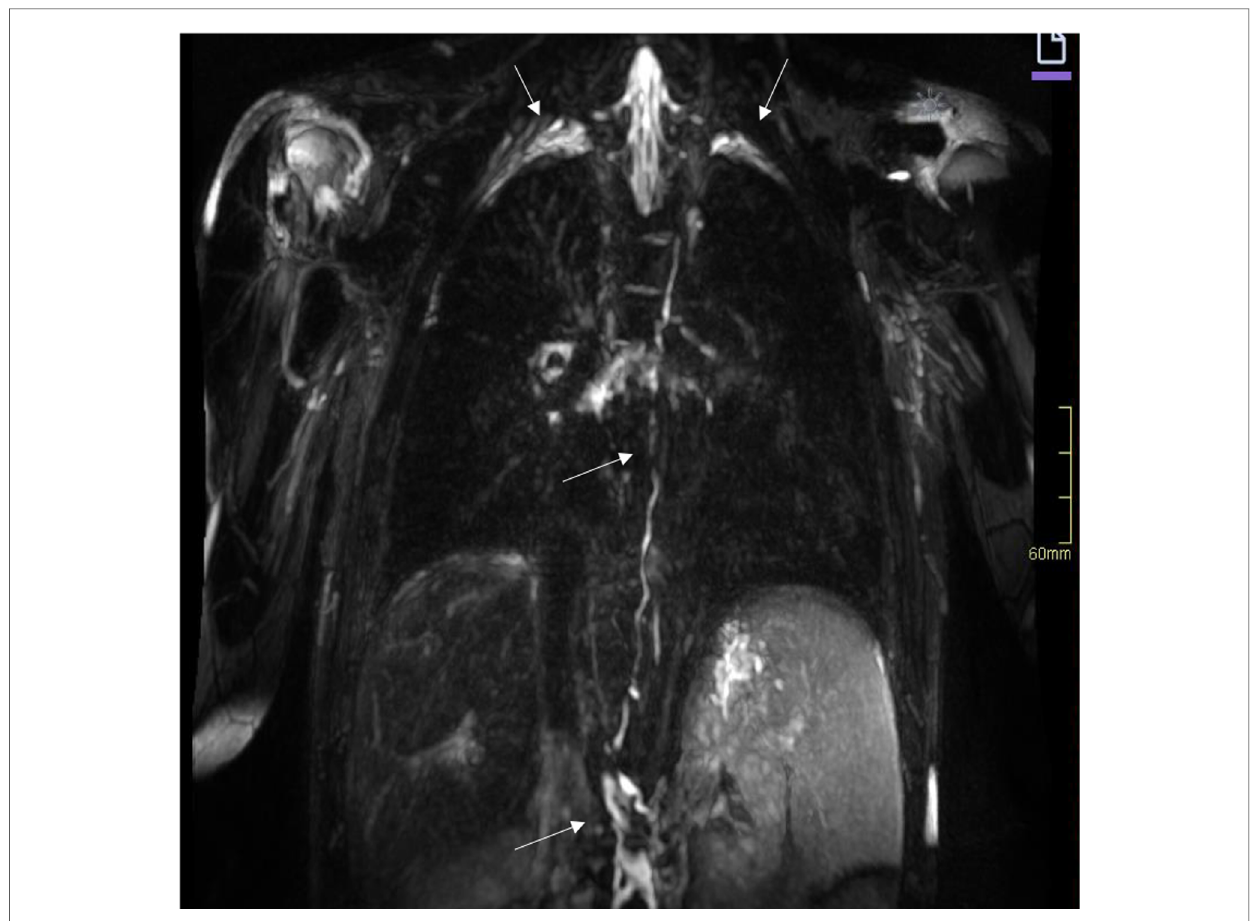
FIGURE 8 MR lymphography of the thorax in a coronal plane with maximum intensity projection, of the same patient as in Figure 6 , reveals a tortuous cisterna chyli and thoracic duct (arrows) and lymphedema in the perihilar region as well as small amounts of pleural effusion over the apices of the lungs (arrows). MR, magnetic